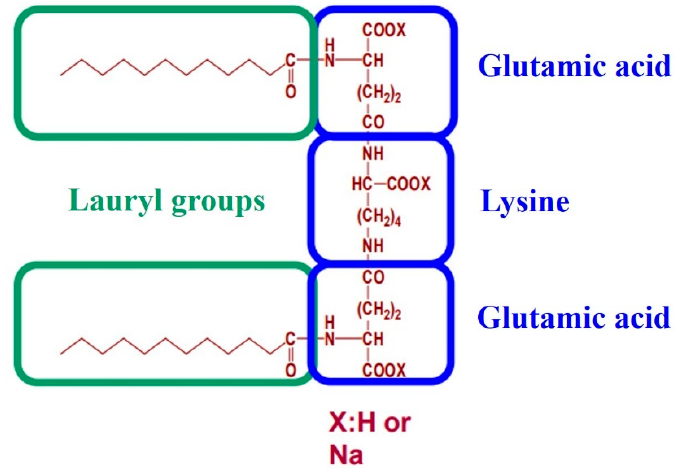
Figure 1. The chemical structure of a gemini surfactant, SLG-30. The hydrophilic moiety of this surfactant has two derivatives of amino acid, i.e., two glutamic acid moieties, linked through a lysine spacer, while the hydrophobic moieties are lauric acid.